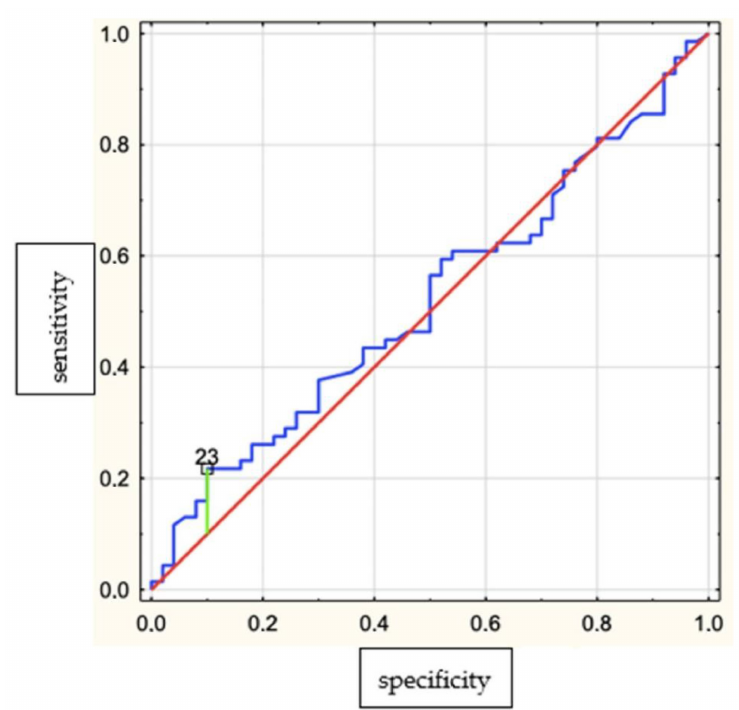
Figure 2. Receiver–operator characteristic (ROC) curve suggesting the optimal AHI cut-off point indicating its suitability for recognizing bruxism (BEI ≥ 2). Yauden’s index = 0.12. The correlation between bruxism parameters and respiratory parameters in the group with AHI < 23 and in the group with AHI > 23 is shown in Table 3. The sensitivity, specificity and accuracy of SBQ (SB > 3 for bruxism diagnosis BEI > 2) were 55.9%, 44.9% and 51.3%, respectively (Figure 3).